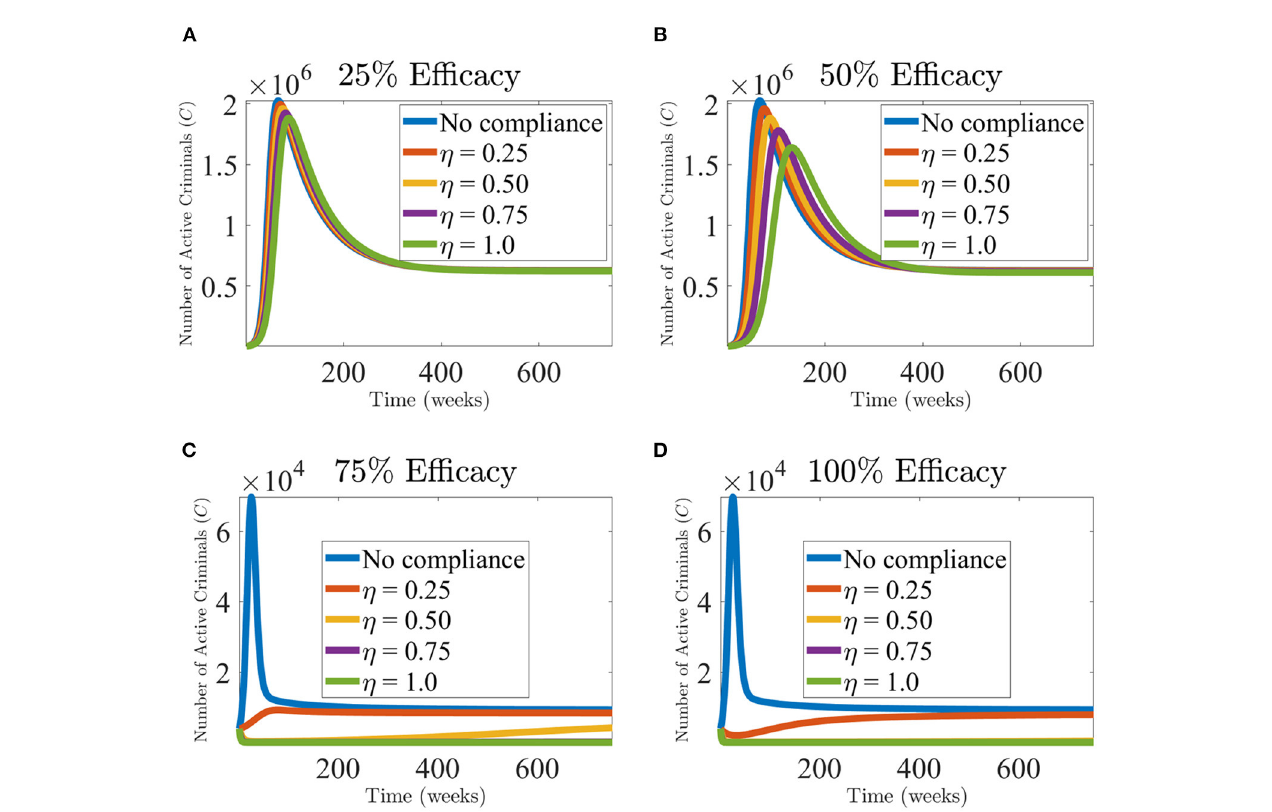
FIGURE4 Effect of intervention programs in the Illinois community. The simulation of the model (Equations 1–3), showing the weekly crime levels, as a function of time, for the assessment of the impact of the intervention programs ( ε ) and the compliance rate ( η ); (A) 25% efficacy of intervention programs, (B) 50% efficacy of intervention programs, (C) 75% efficacy of intervention programs, and (D) 100% efficacy of intervention programs for Illinois. Allowing for the assessment of the combined effect of the intervention strategies and how the masses comply with the policies. The improvement in the intervention strategies and compliance rate are measured in terms of the percentage reduction of crime levels in Illinois. The other parameter values used are given in Tables 3,